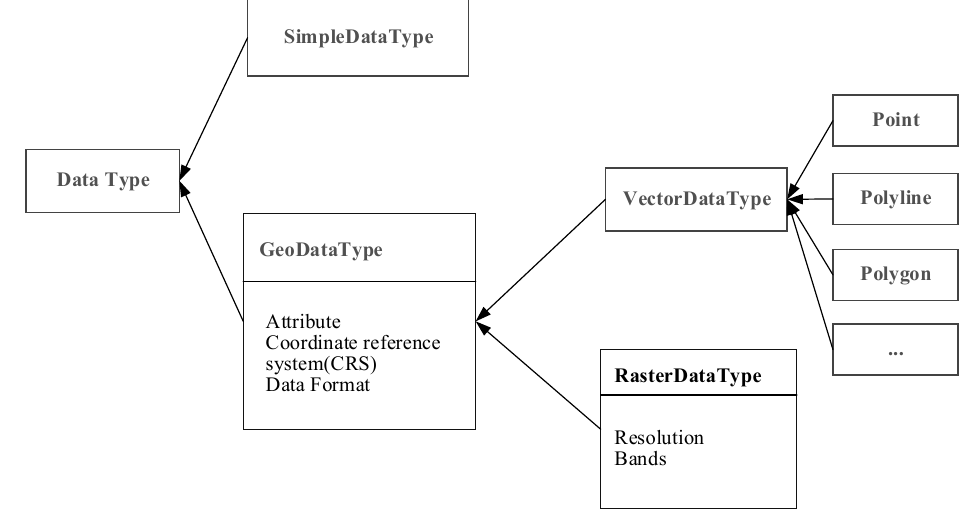
Figure 6. Data type specifications.